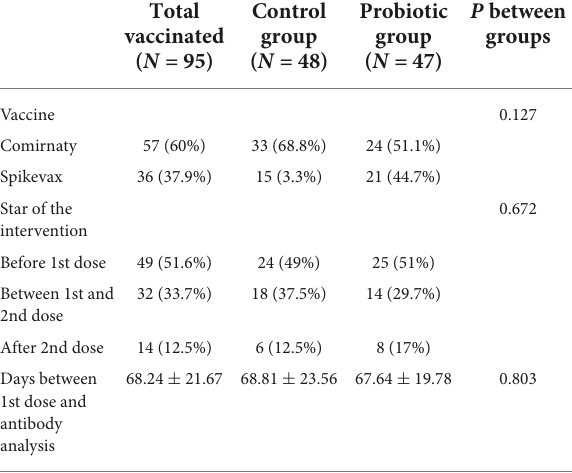
TABLE 2 Data related to the COVID-19 vaccine of the subgroup of subjects receiving the vaccine during